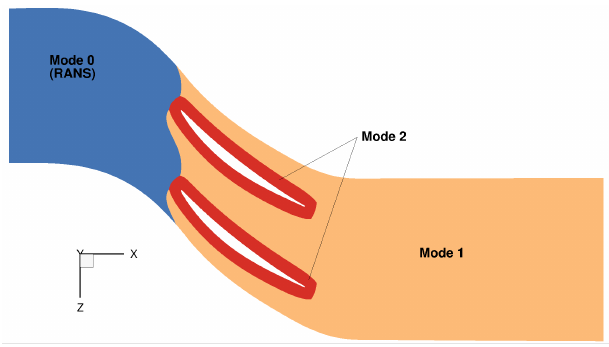
Figure 8. ZDES mode distribution in blade-to-blade view. The mode 2 is used in the tip gap (O-H